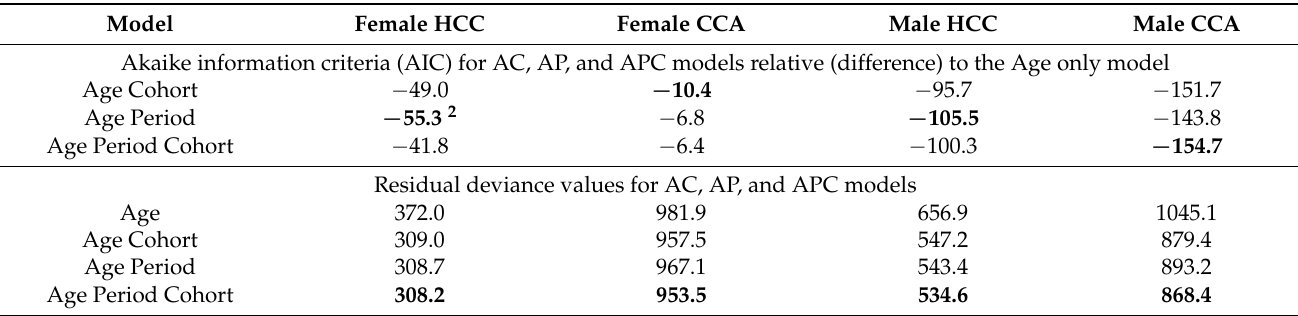
Table 3. Akaike information criteria (AIC) 1 and residual deviance for APC models. Model Female HCC Female CCA Male HCC Male